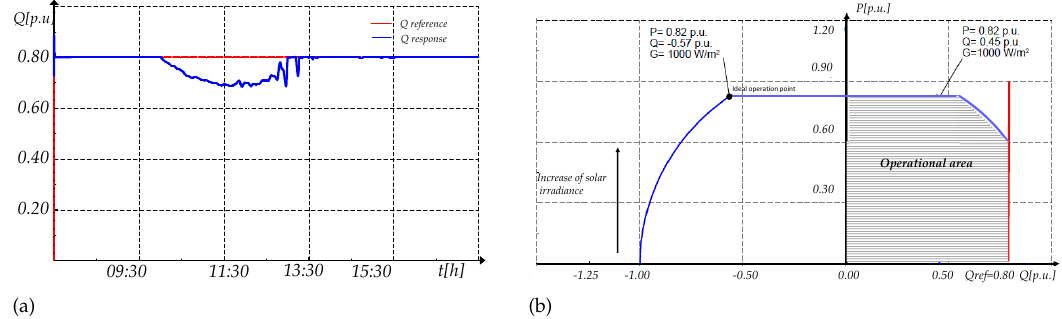
Figure 25. Injected reactive power with MPPT control and M = 1 ( a ) Response of reactive power and ( b ) Operational area.